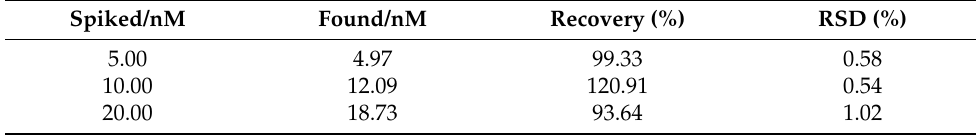
Table 1. Determination results of copper ions (Cu 2+ ) in pure water of Watsons samples ( n = 3). Spiked/nM